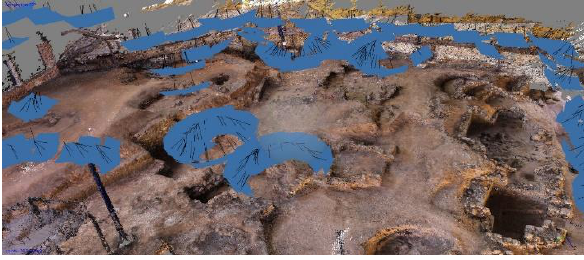
Figure 7. Photogrammetric model in which each camera position is displayed in blue.